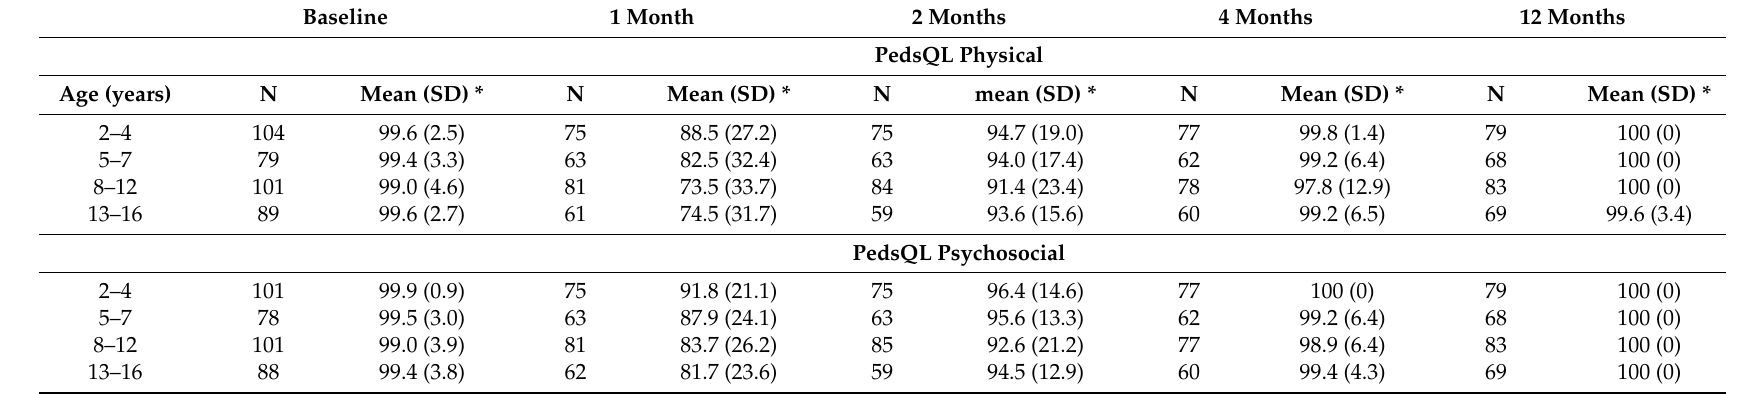
Table 5. PedsQL by age group in children aged 2–16 years at baseline, 1, 2, 4, and 12 months after